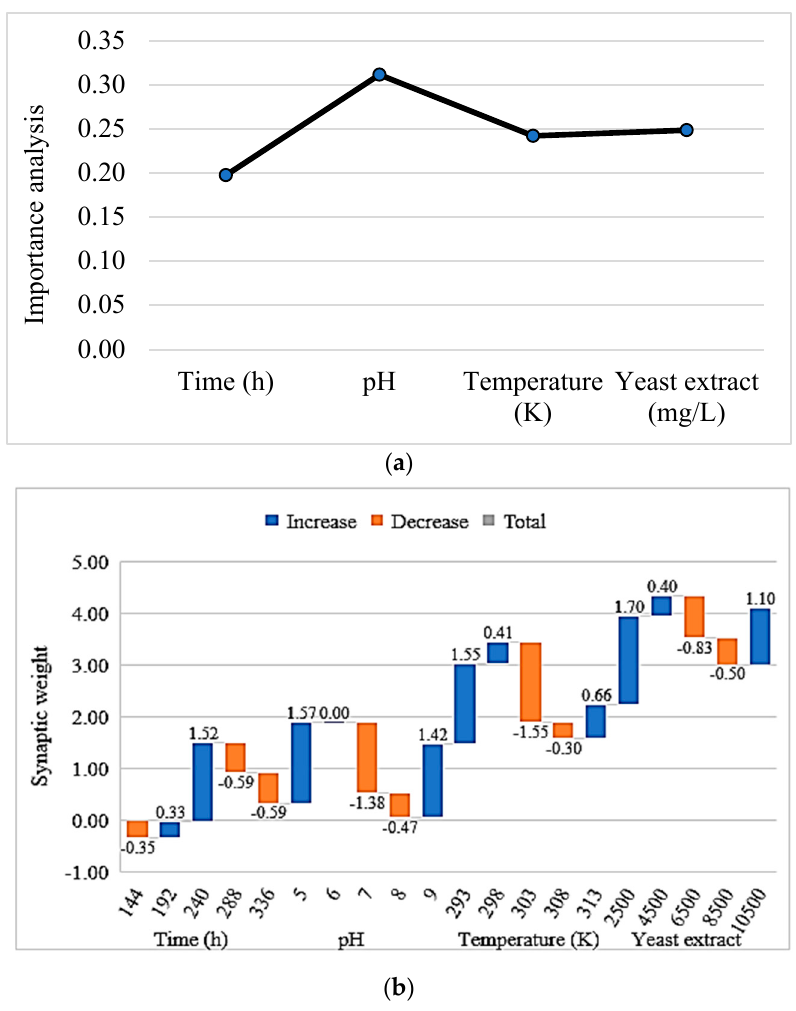
Figure 7. ( a ) level of importance analysis of the various input parameters; ( b ) parameters estimates based on the synaptic weights.